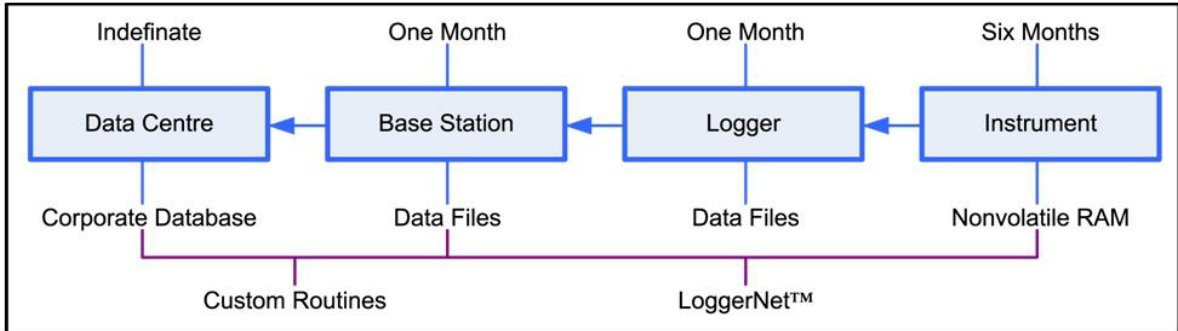
Figure 3. ―Store and Forward‖ data flow schematic showing the components involved, the data storage mechanisms, data storage times (top) and the software used (bottom) to co-ordinate the data